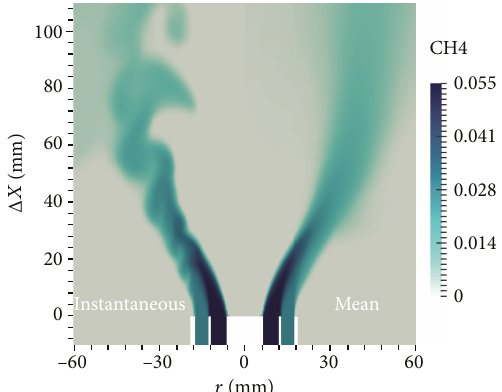
mass fraction 4